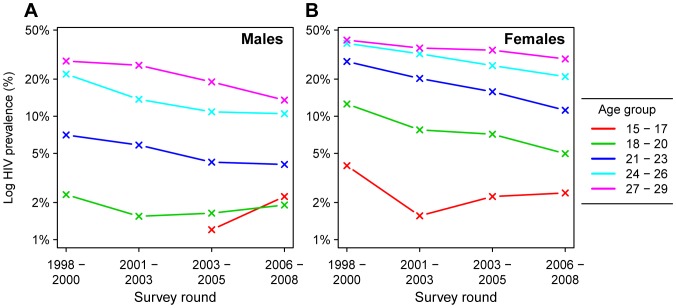
HIV prevalence in adolescents and young adults in the Manicaland HIV/STD Prevention Project.Age-specific HIV prevalence for males (panel A) and females (panel B) by 3-year age groups. Prevalence is represented on the logarithmic scale to illustrate trend at low prevalence levels.